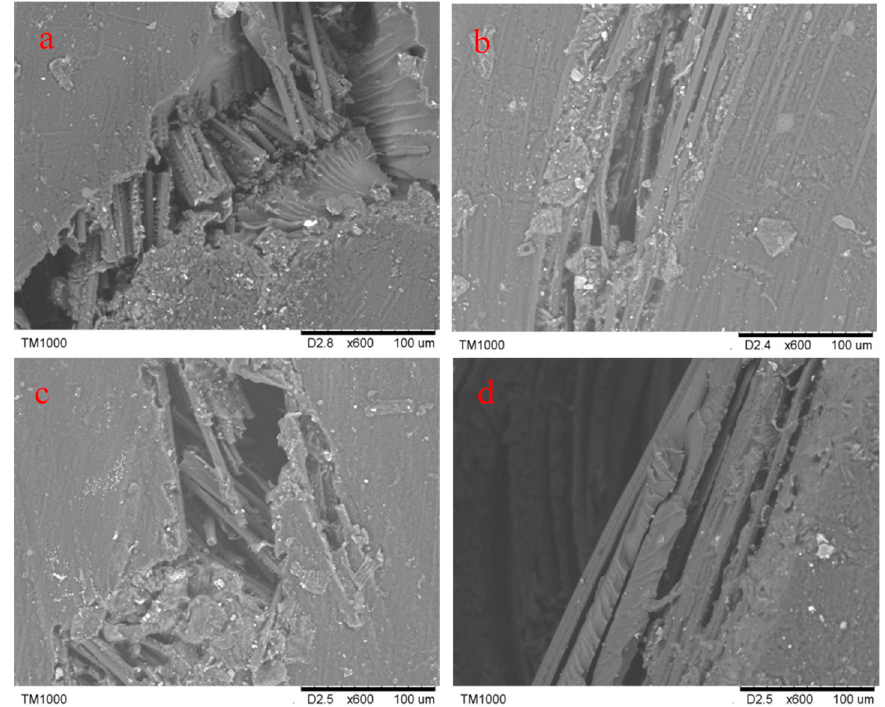
Figure 11. Electron micrograph of lateral crack after bending fracture in 3Dim–5Dir braided composites at 110 °C with different durations ( a ) at room temperature; ( b ) 110 °C 0.25 h; ( c ) 110 °C 10 h; ( d ) 110 °C 30 h.